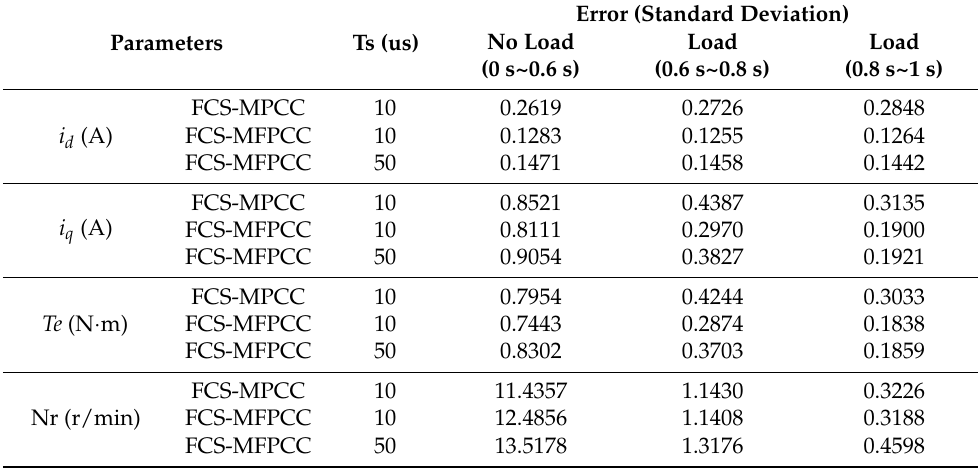
Table 2. Errors of different control methods.